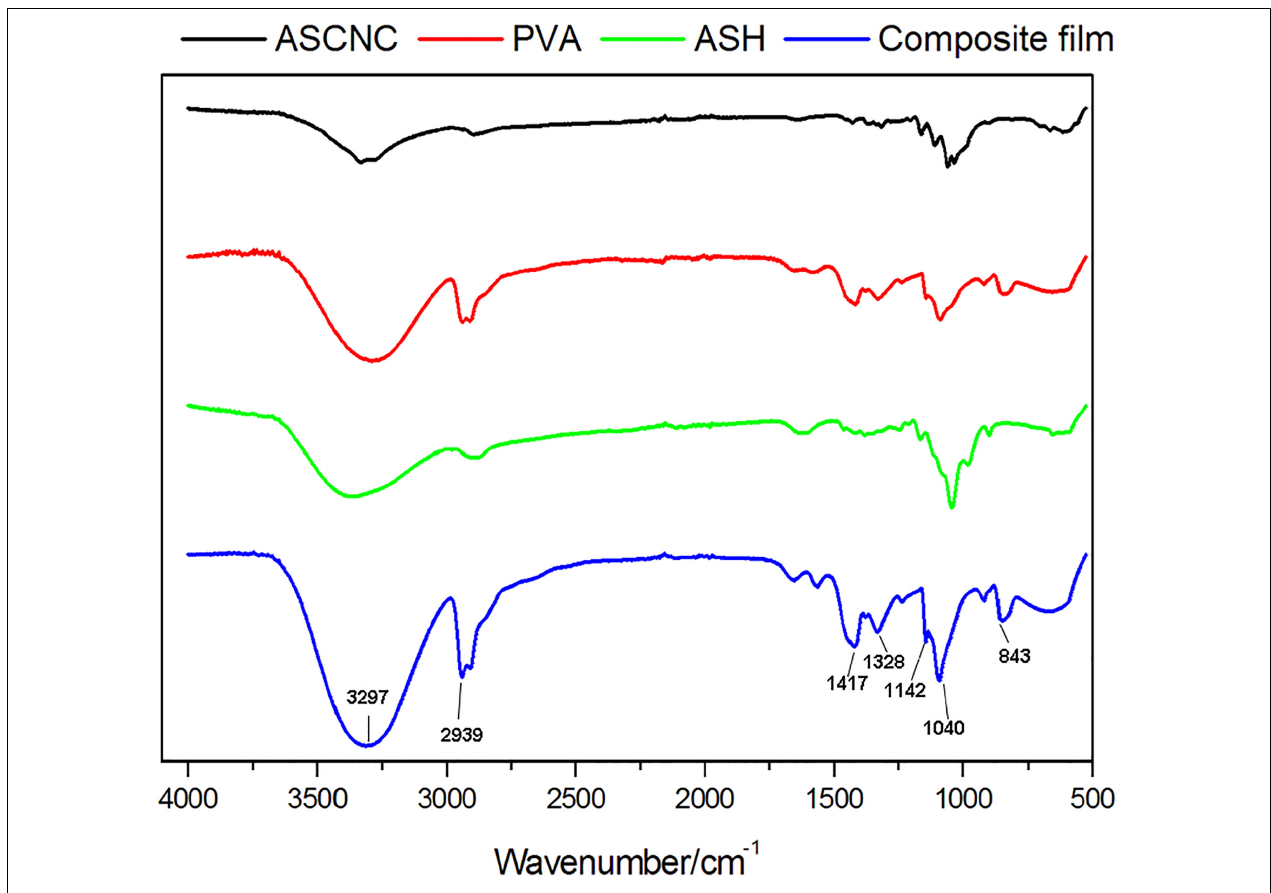
FIGURE 7 | Infrared spectrum of the composite film and its major